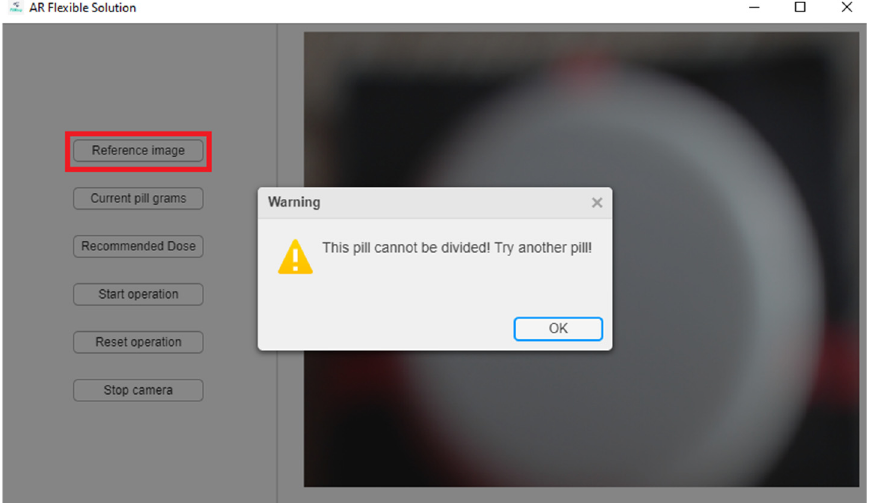
Figure 5. Error message as a result of the pill line not being identified.